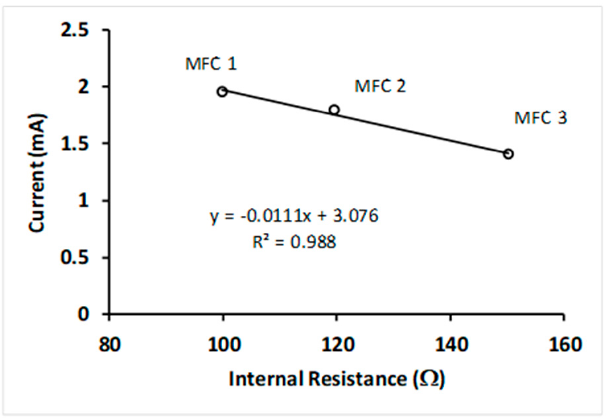
Figure 4. Current vs. internal resistance in MFC 1, MFC 2 and MFC 3.